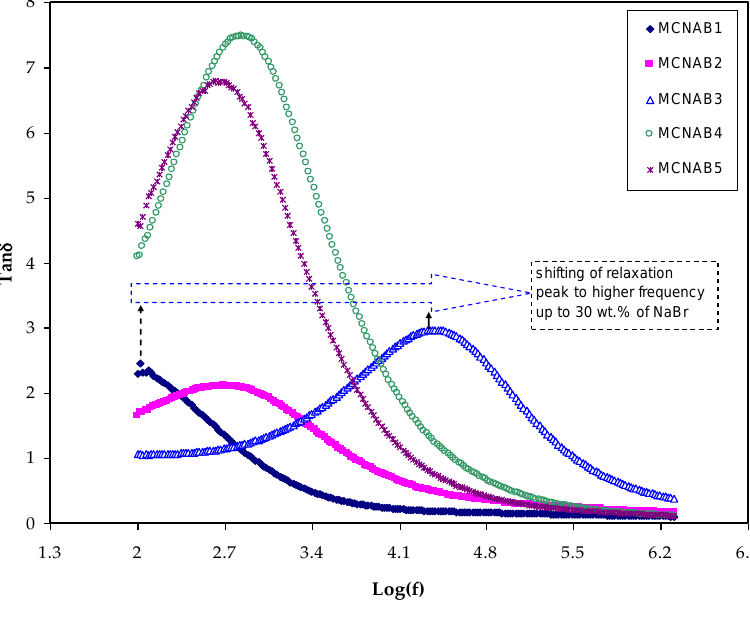
Figure 8. The tan δ for the samples.